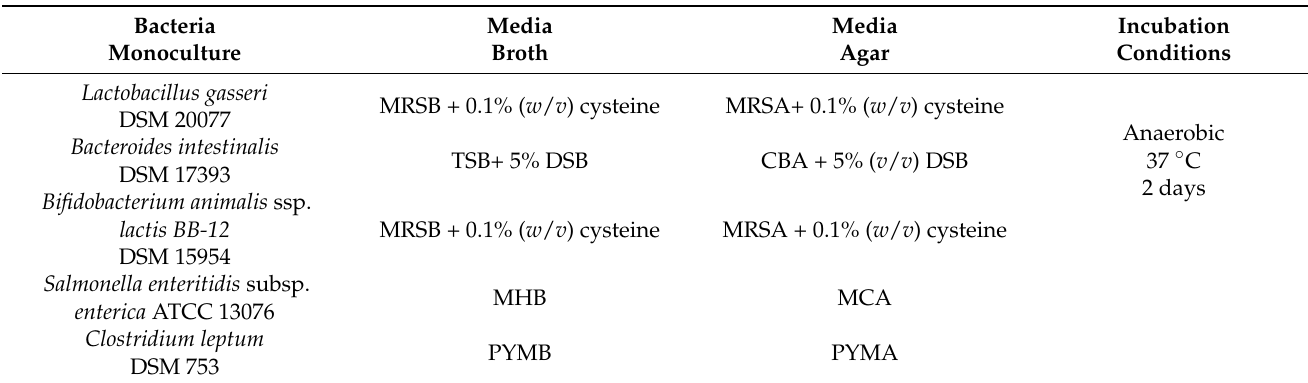
Table 3. Bacteria monocultures used as genomic DNA standard for calibration curves and their growth